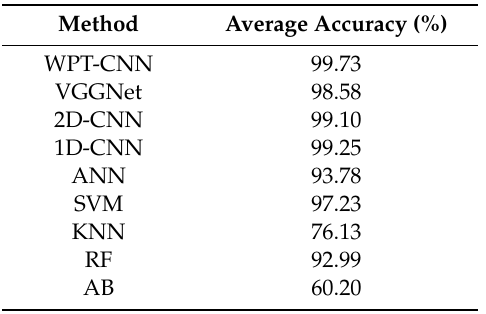
Table 6. Comparison result on Dataset A in Case One.